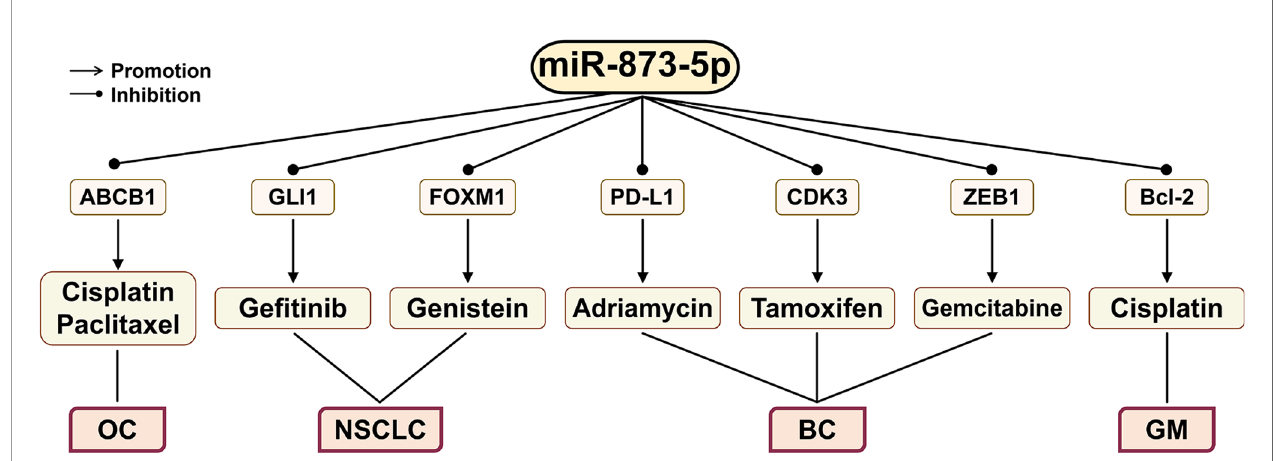
FIGURE 6 | The effect of miR-873-5p on the ef fi cacy of different cancer chemotherapy drugs through its target genes. miR-873-5p inhibits the expression of ABCB1, Bcl-2, GLI1, FOXM1, PD-L1, CDK3, and ZEB1, thereby improving the inhibitory effects of various anticancer drugs on cancer cells. OC, ovarian cancer; GM, glioblastomas; LC, lung cancer; BC, breast